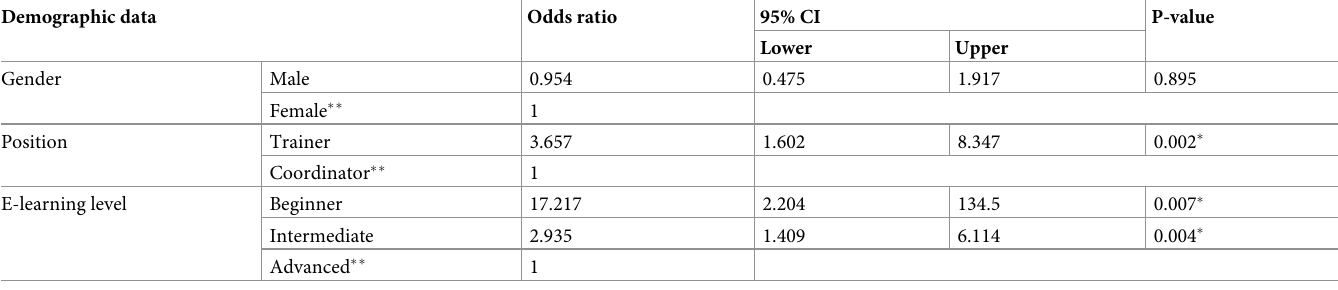
Table 6. Univariate logistic regression for factors associated with barriers to e-learning experienced by trainers and